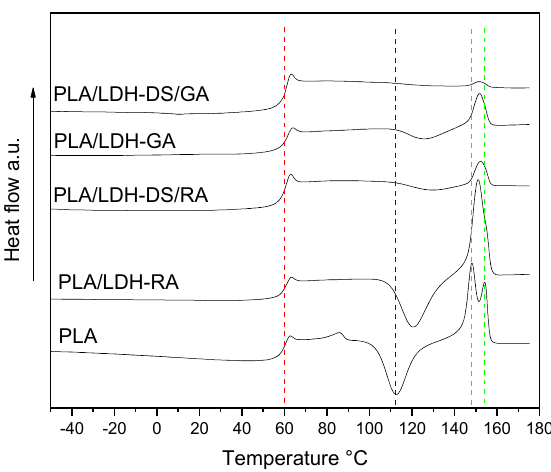
Figure 8. DSC curves (2 nd heating) of PLA, PLA/LDH-RA, PLA/LDH-GA, PLA/LDH-DS/RA, and PLA/LDH-DS/GA. The red, blue, and green dashed lines indicate the fundamental transitions of pure PLA: glass transition, cold crystallization, and melting.